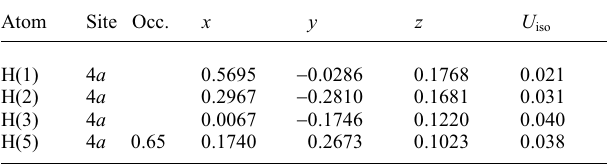
Table 2. Atomic coordinates and displacement parameters (in Å 2 )